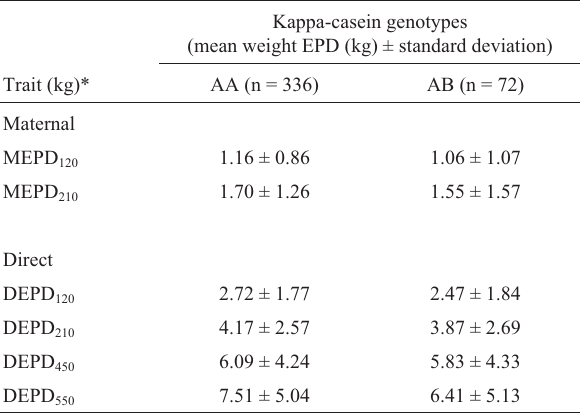
Table 1 - Weight (kg) expected progeny difference (EPD) values for a sample of 408 Brazilian Nellore cattle genotyped for the Kappa-casein CSN3 ( Hinf I) polymorphism.